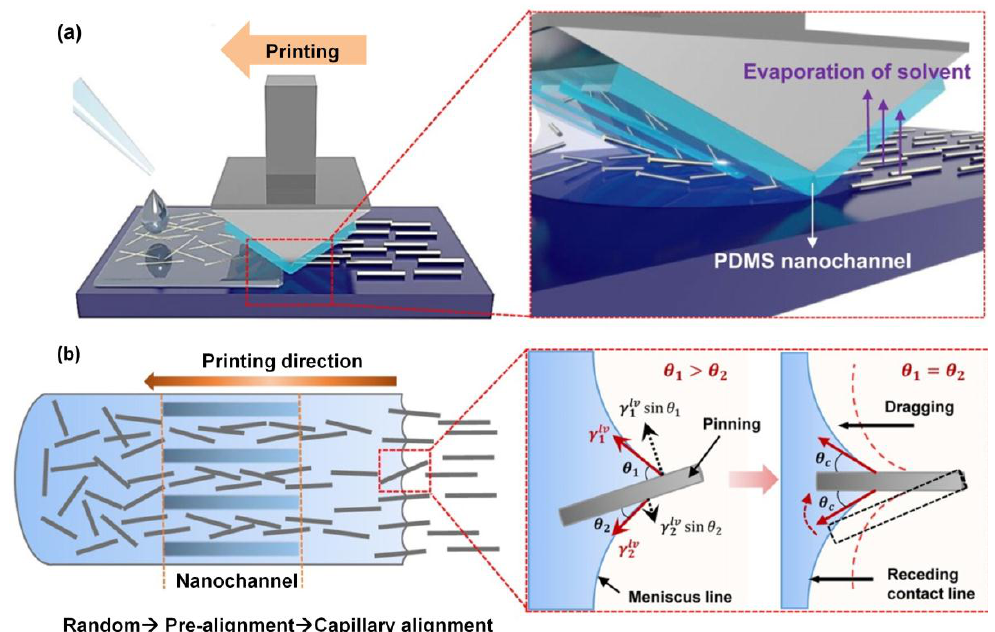
Figure 5. Solution-printed highly aligned Ag nanowire (NW) arrays: ( a ) Schematic of the capillary printing process using a nanopatterned polydimethylsiloxane (PDMS) stamp to produce highly aligned NW arrays; ( b ) Schematic showing the alignment process during capillary printing of unidirectional NW arrays. The solvent-evaporation-induced capillary force produces highly aligned networks by dragging confined NWs at the solid-liquid-vapor contact line. (Reproduced with permission from [68]. Copyright American Chemical Society, 2015).